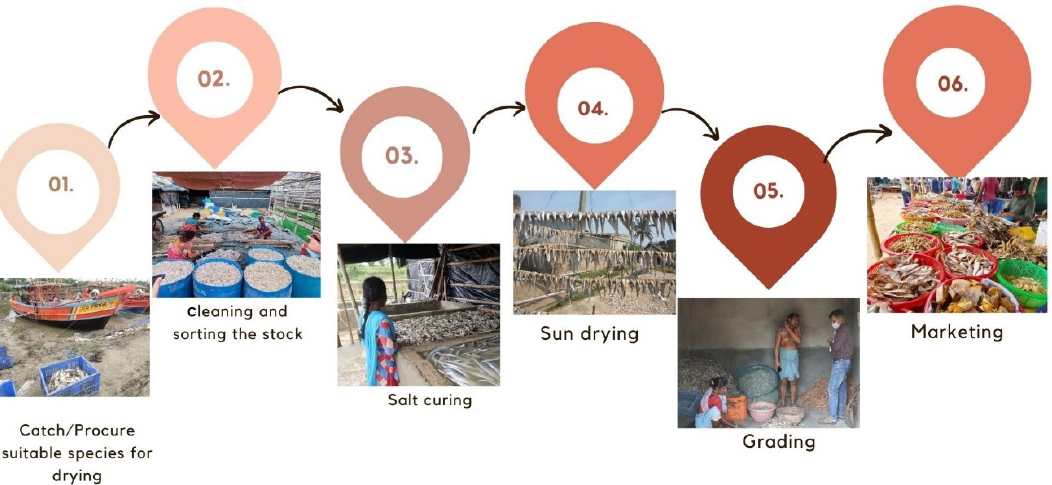
Figure 3. Process steps involved in the dried fish value chain from fish catch to final disposal in the market in the case-study locations as shown in Figure